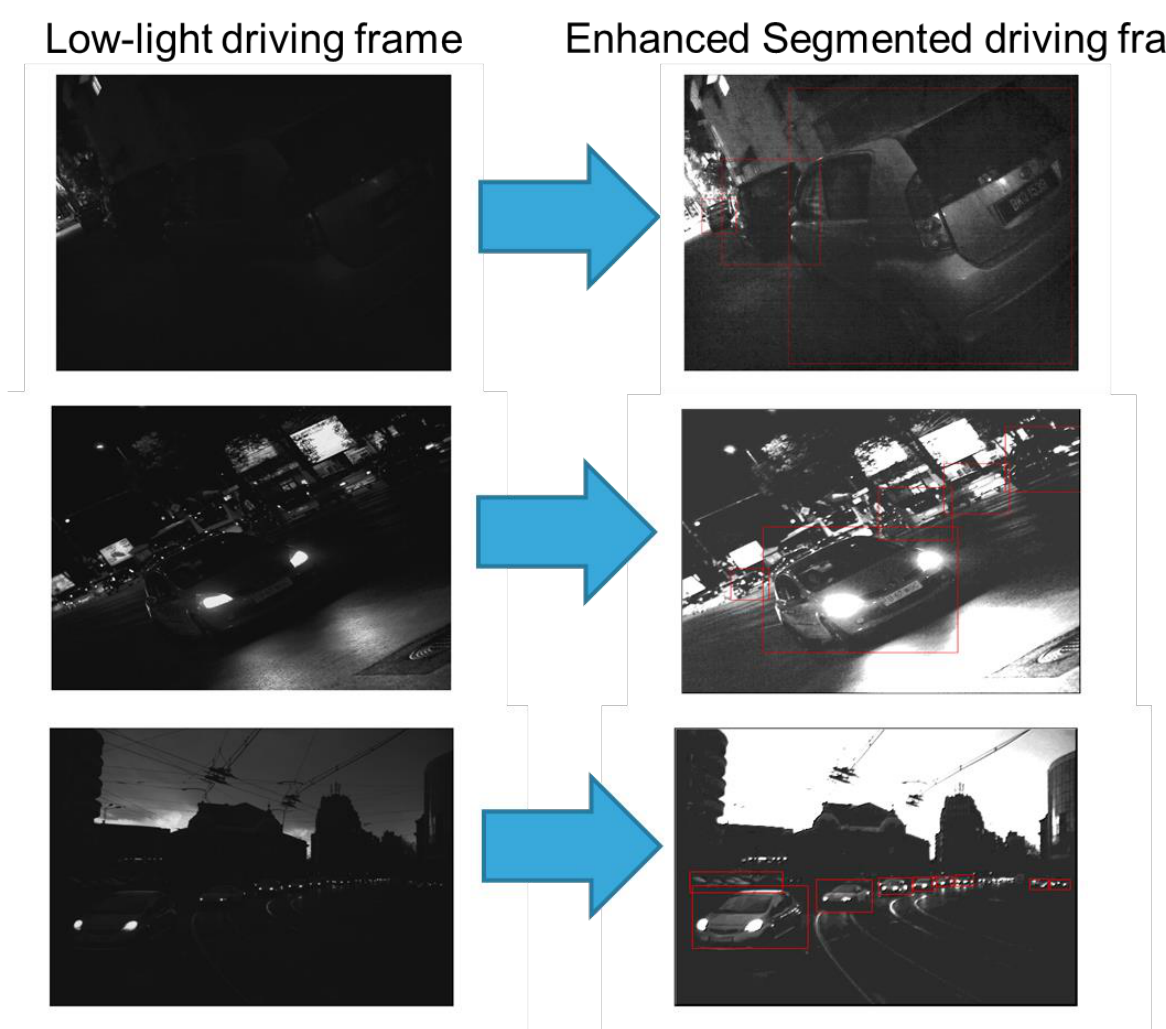
Figure 6. Some instances of the low-light driving frames with corresponding enhanced and segmented frames.